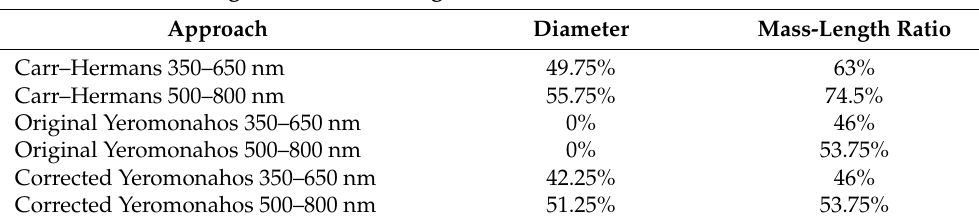
Table 3. Percent of investigated diameter/length combinations in which each approach and wavelength range provided less than 10 percent error in the calculations of diameter and mass–length ratio. % of Investigated Diameter/Length Combinations with Less than 10% Error